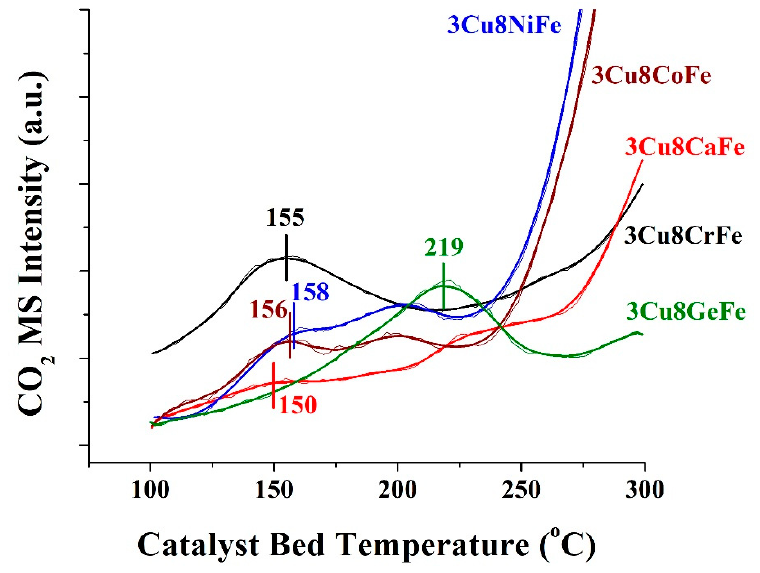
Figure 3. CO 2 evolution of 3Cu8MFe catalysts (M = Cr, Ca, Ni, Co and Ge) as a function of catalyst bed temperature. The thin zigzag line represents the actual data points and the bold solid line passing through the data points is the moving average for the respective data points in each curve. Calibration of the CO 2 mass spectrometer signal, number of catalytic active redox sites (N s ) for each catalyst, was achieved with CO-Temperature Programmed Reduction of known quantities of bulk CuO (see calibration curve in Figure S3).